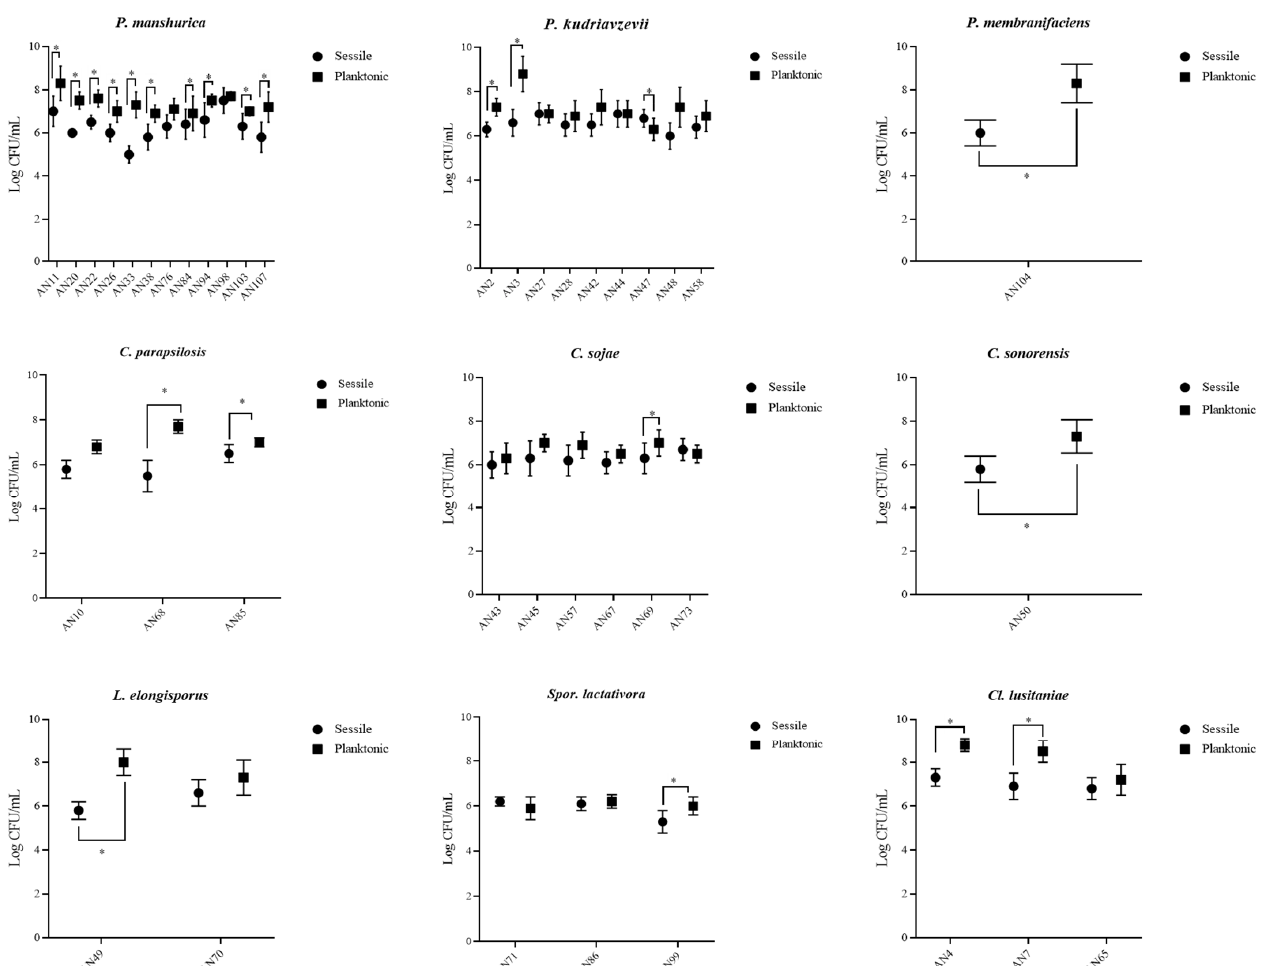
Figure 1. Viable yeast cell counts in planktonic and sessile states on polystyrene surface. * p < 0.05